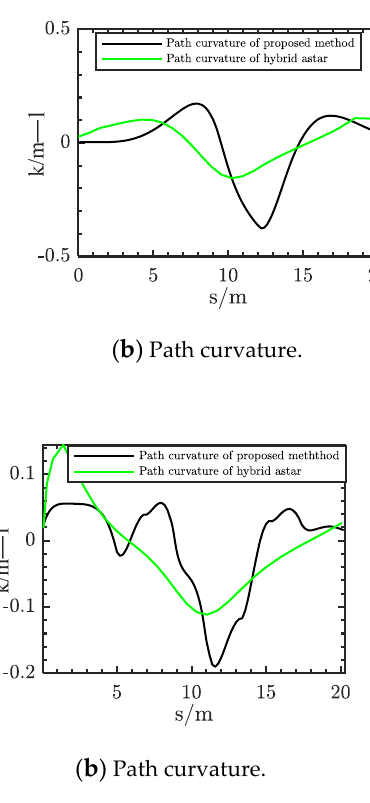
Figure 8. Planned result in Scenario 2.